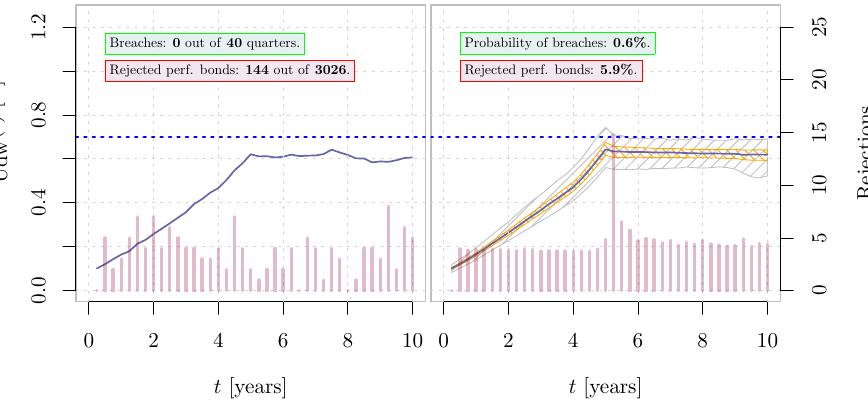
Figure 5. Dynamics of SCR Udw ( t ) , given the notation introduced in Figure 4. RAF introduced in Definition 1 is applied to estabilish the management actions